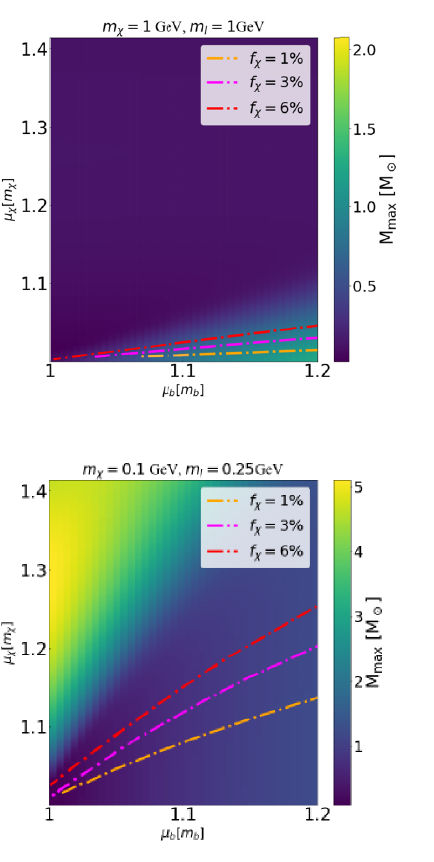
Figure 3. Parameter space in the μ χ − μ b plane calculated for the IST EoS and di ff erent values of model parameters: m χ = 1 GeV, m I = q GeV (upper left panel), m χ = 1 GeV, m I = 2 GeV (upper right panel), = 0.1 GeV, m = 0.25 GeV (lower left panel), m = 0.1 GeV, m = 1 GeV (lower right panel). The color m I I χ χ represents the total maximum gravitational mass of DM-admixed NSs. The yellow, magenta, and red dash-dotted curves correspond to the DM fraction, 1%, 3%, and